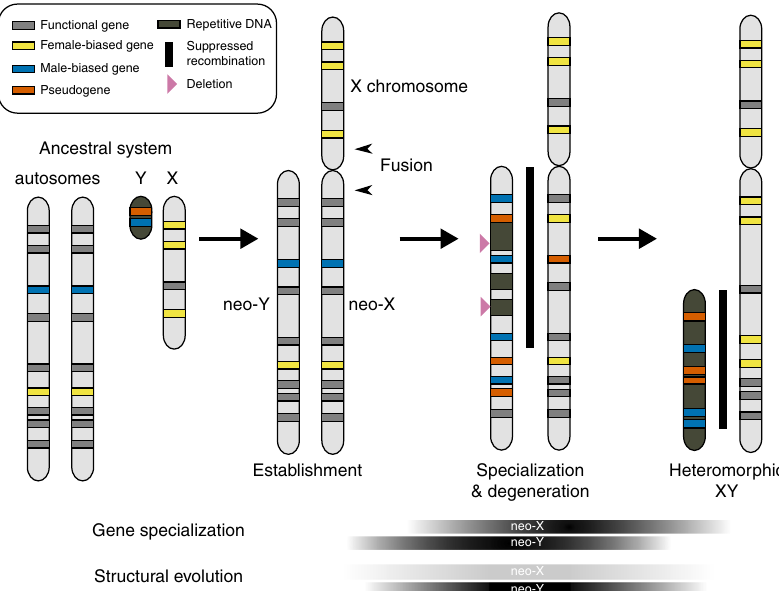
Fig. 1 Neo-sex chromosome evolution. The predicted stages of heteromorphic differentiation are shown left to right for a neo-XY pair formed from a fusion between an X chromosome and an autosome. The relative timing and intensity of sex-speci fi c gene specialization and structural evolution are depicted for the neo-X and neo-Y separately (shaded boxes, bottom). Following establishment, the neo-sex chromosomes are expected to undergo sex-biased gene specialization and at least some structural evolution dependent on the cessation of recombination. Both processes should occur more rapidly and be more extensive on the male-speci fi c neo-Y chromosome. As seen in highly heteromorphic sex chromosomes, the evolution of heteromorphic neo-sex chromosomes is also predicted to further contribute to reproductive isolation through the exposure of recessive genetic incompatibilities and more rapid sex-linked divergence in the heterogametic sex. The fate of the highly degenerate ancestral Y chromosome is not shown and is often unclear in X- autosome fusions. Figure adapted from Bachtrog